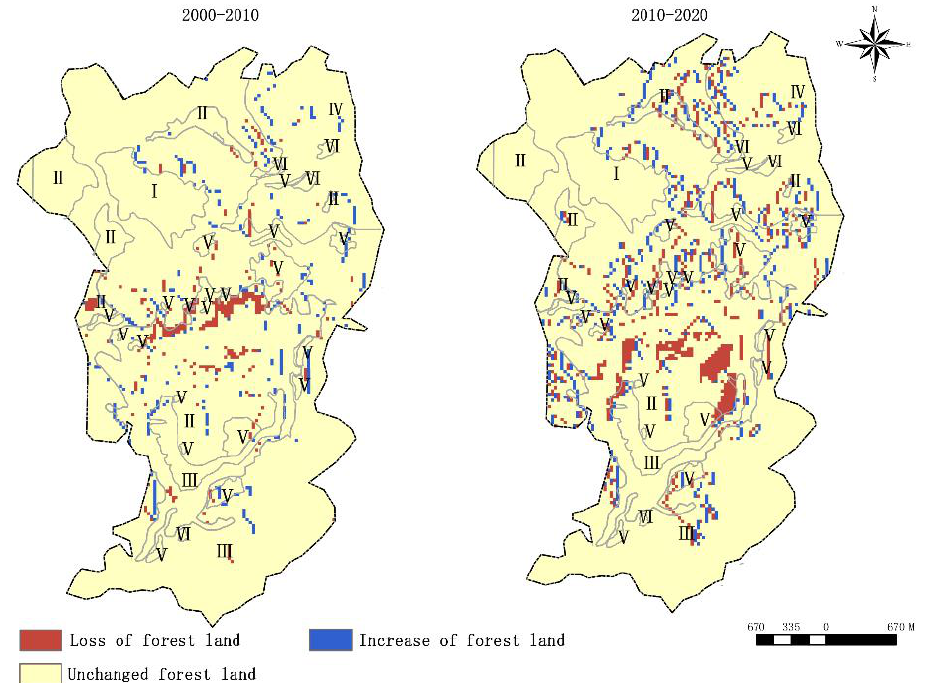
Figure 6. Map of forest land change from 2000 to 2020. Note: I is a special protection zone, II is a scenic tour area, III is a scenic restoration area, IV is a scenic coordination area, V is a tourism service area, and VI is a development control area.